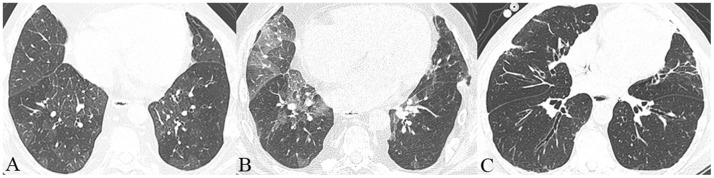
Typical CT findings of BOS include bronchial wall thickening (A), mosaic attenuation (A), air trapping (B) and bronchiectasis (C).